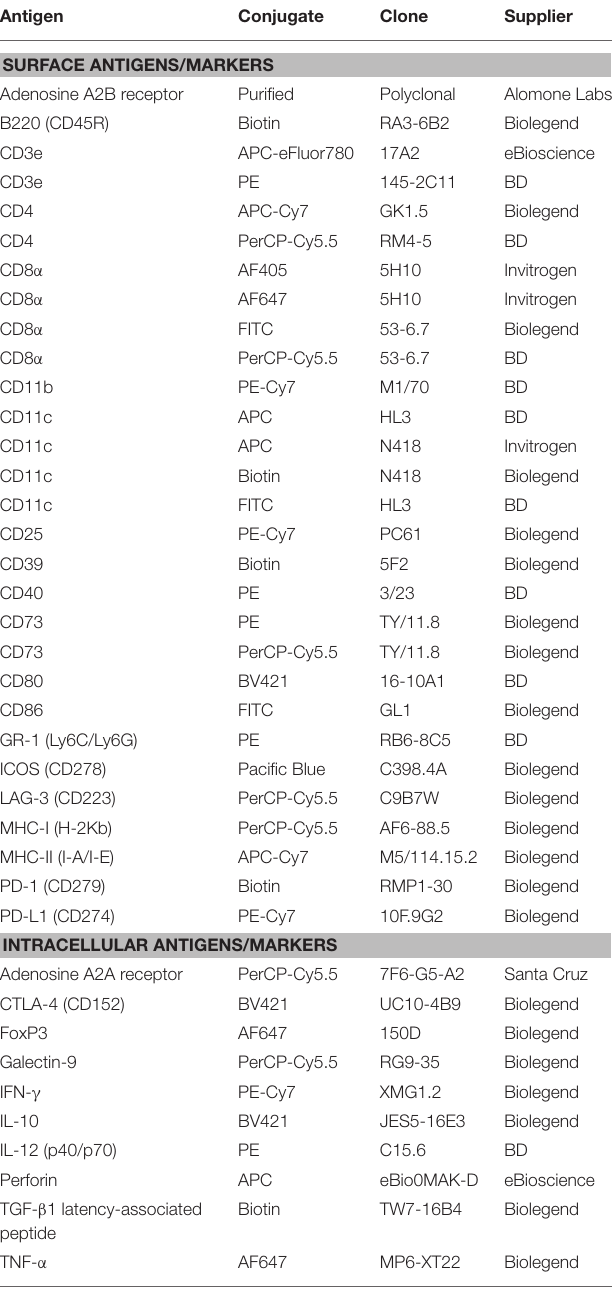
TABLE 1 | Anti-mouse antibodies used in this